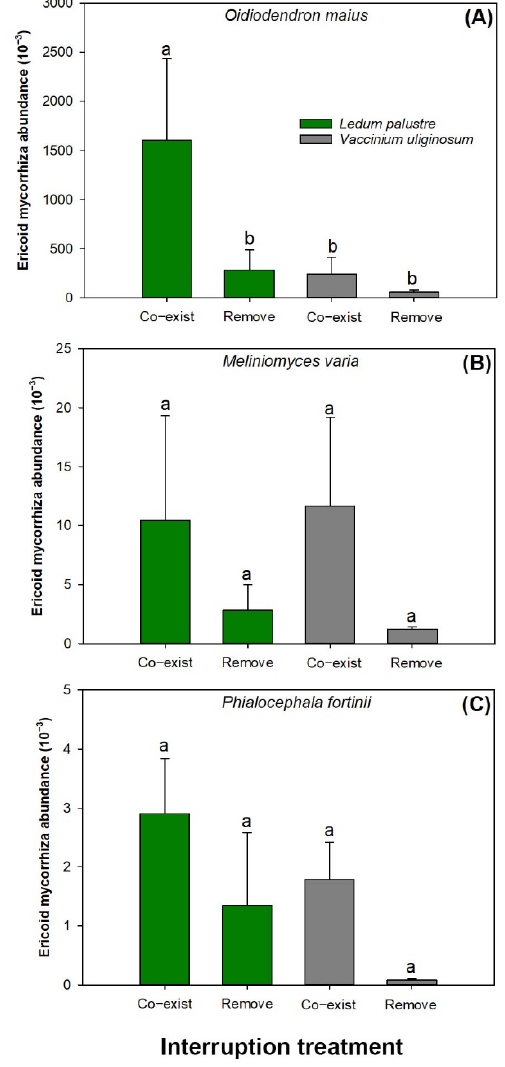
Figure 4. Ericoid mycorrhiza abundances of Oidiodendron maius ( A ), Meliniomyces variabilis ( B ), and Phialocephala fortinii ( C ) in soils of communities dominated by Ledum palustre and Vaccinium uliginosum in the interruption treatment of dominant species removal and an untreated control of both species co-existing. Columns stand for means with error bars marking standard errors. Different letters label significant difference according to a Tukey test at 0.05 level.